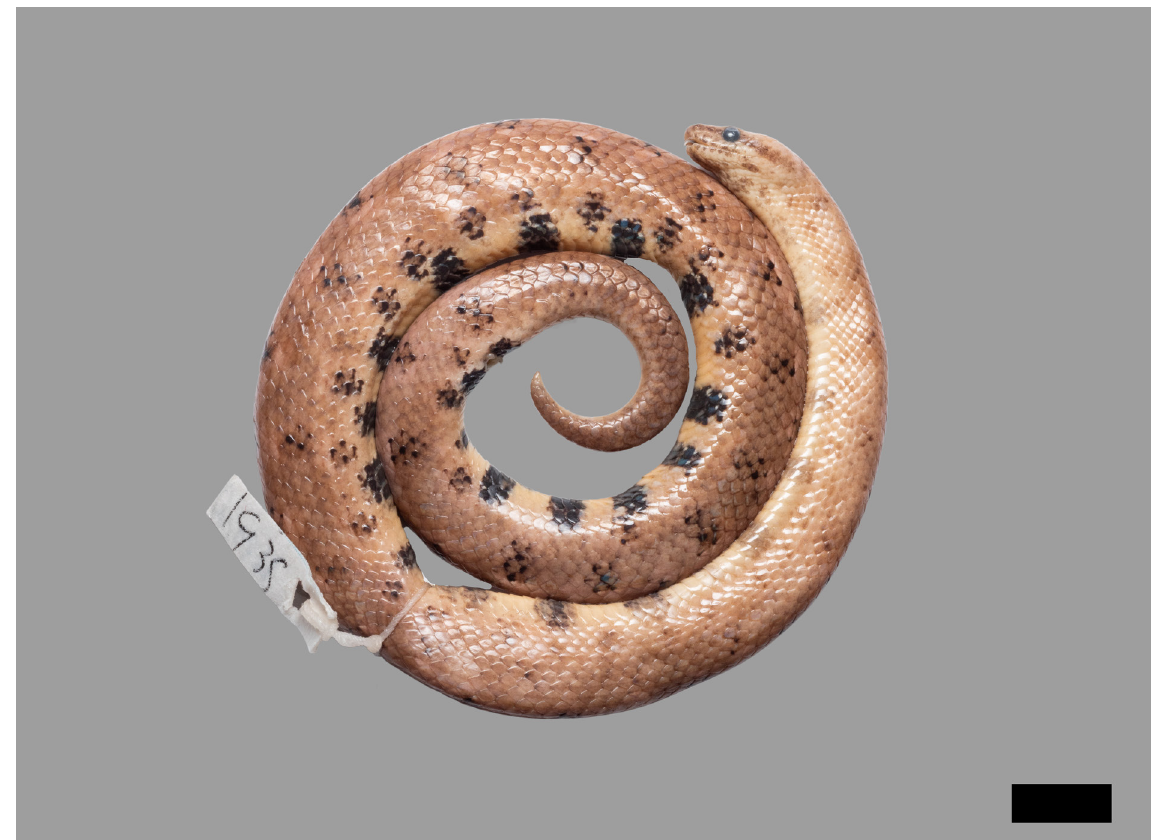
Fig. 5. Lateral view of Tropidophis cauangoae sp. nov., ♀, paratype (DHMECN 15893). Scale bar = 10